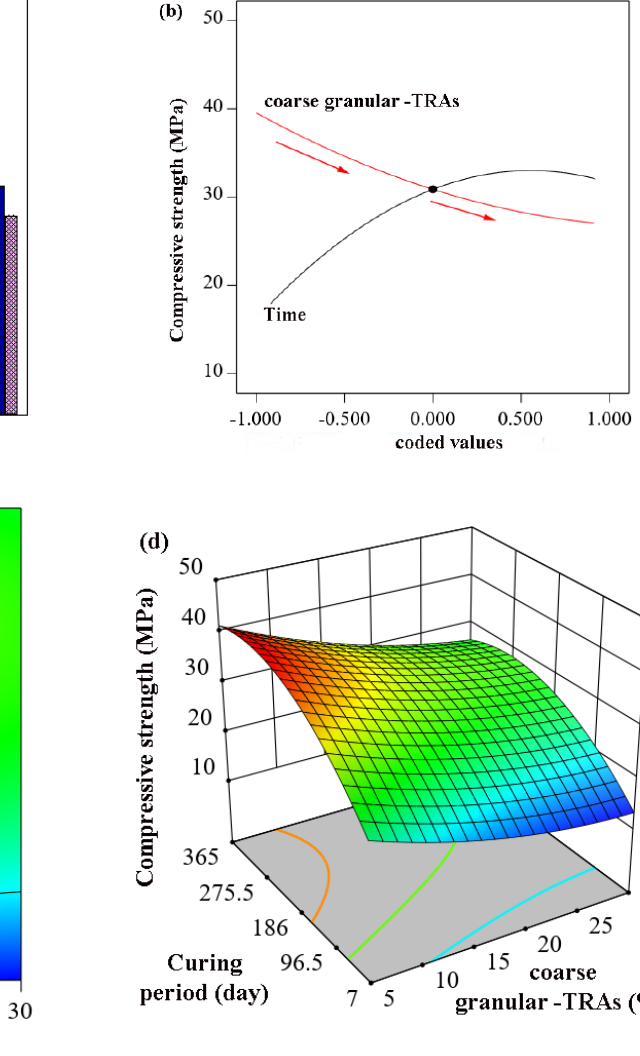
Figure 9. Effect of POFA concrete containing coarse granular-TRAs on compressive strength ( a ) Ex- perimental work ( b – d ) RSM model. ( a ) Experimental work ( b – d ) RSM